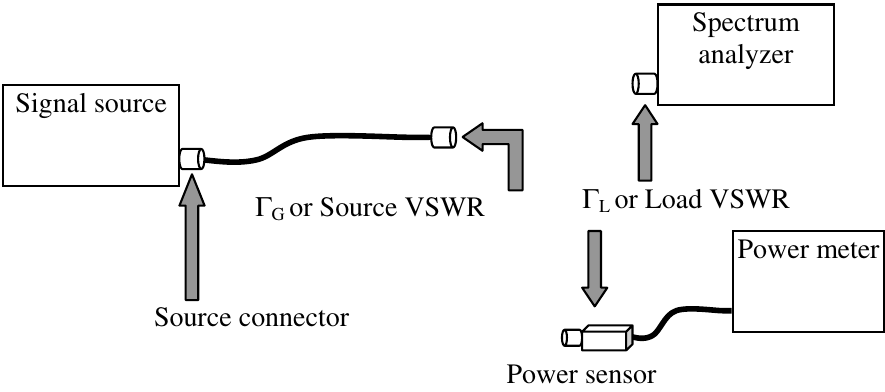
Fig. 4. Illustrations for Γ or VSWR measurement